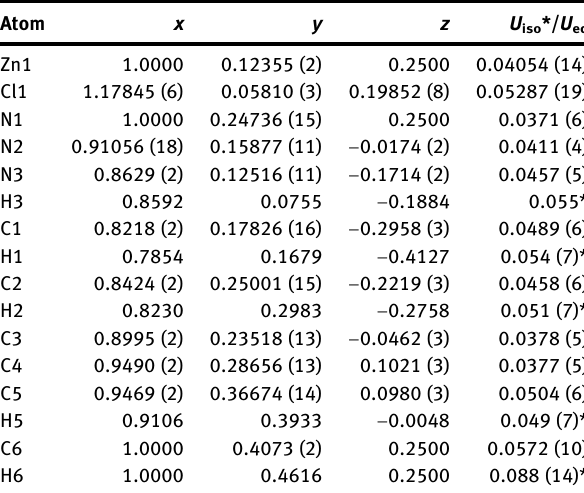
Table  : Fractional atomic coordinates and isotropic or equivalent isotropic displacement parameters (Å 